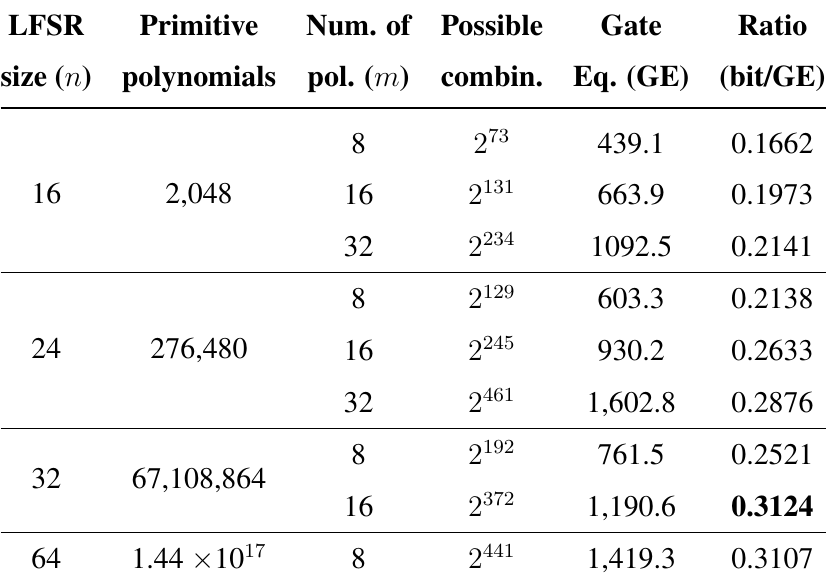
Table 2. Combinations using primitive